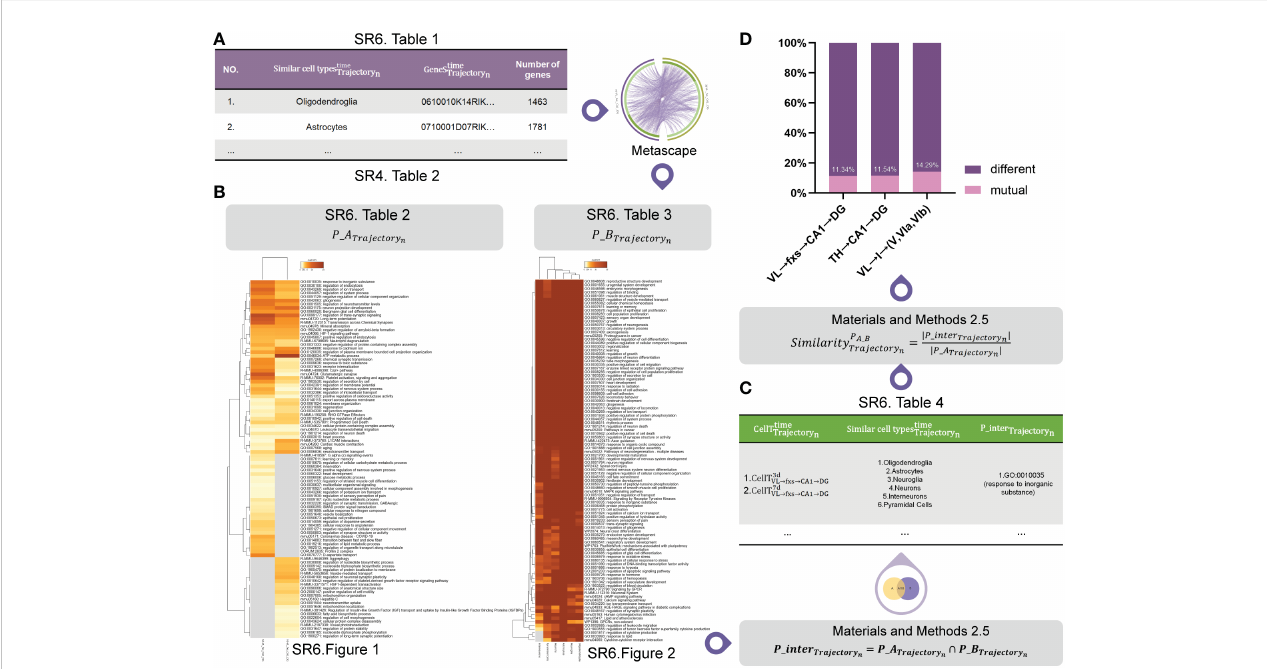
FIGURE 6 Pathway analysis. (A) The marker genes of similar cell types. (B) The mutual pathway sets for our identi fi ed cell subtypes P _ A Trajectory . (C) The mutual pathway set P _ inter Trajectory between our identi fi ed cell subtypes P _ A Trajectory types P _ B Trajectory n n and P _ B Trajectory (D) The similarity between P _ A Trajectory n n